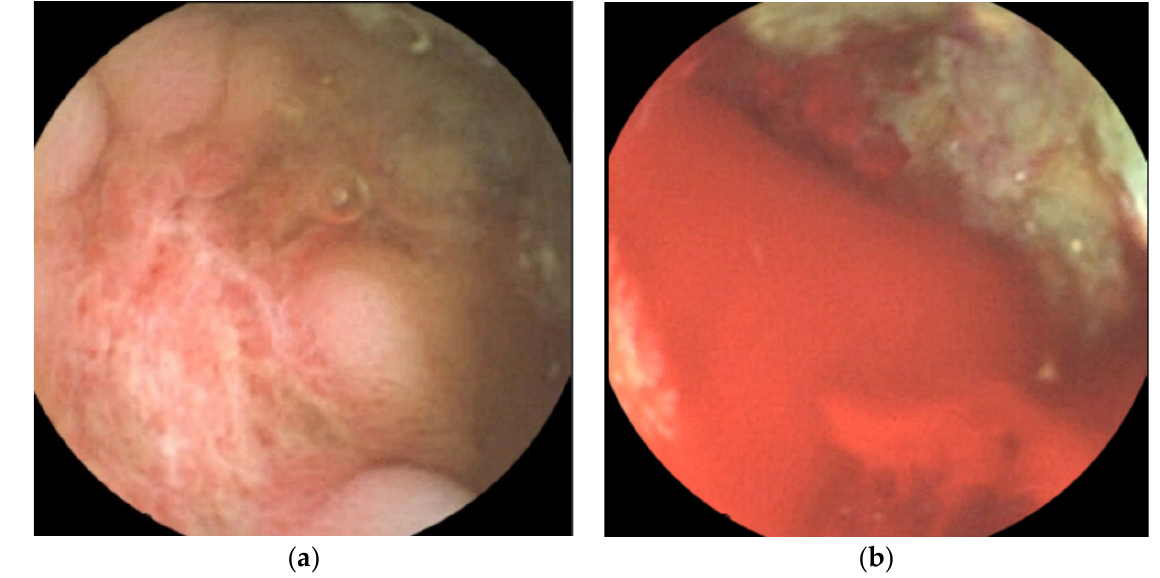
Figure 5. Capsule endoscopy revealed three or more ulcers of various sizes ( a ) and active bleeding in the distal ileum ( b ). Table 1. Laboratory